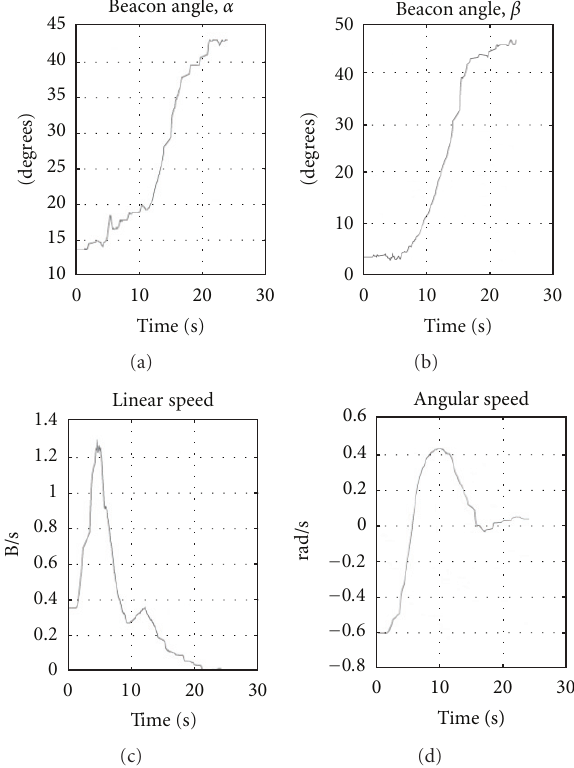
Figure 17: The changes in α , β , and the control signals for the third experiment.